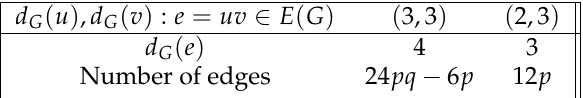
Table 6. Edge degree partition of VC 5 C 7 [ p , q ]